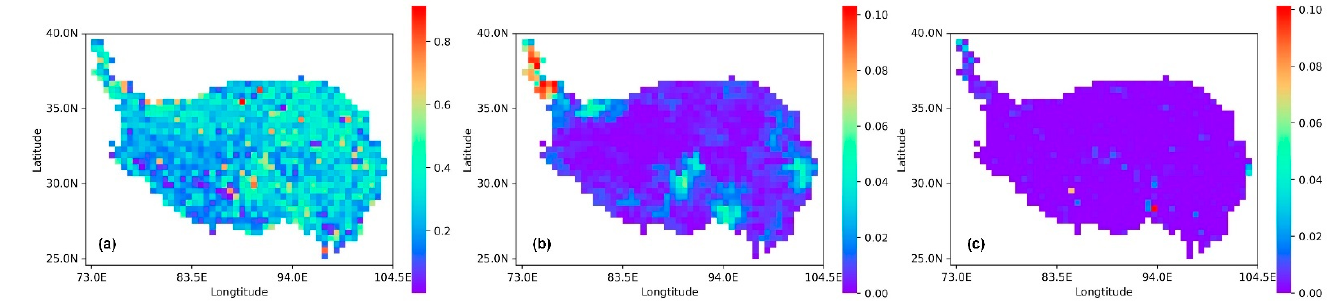
Figure 15. ( a ) The frequency of STIRAs in the testing dataset; ( b ) the frequency of PTIRAs in the testing dataset; ( c ) the frequency of earthquakes in the testing dataset.